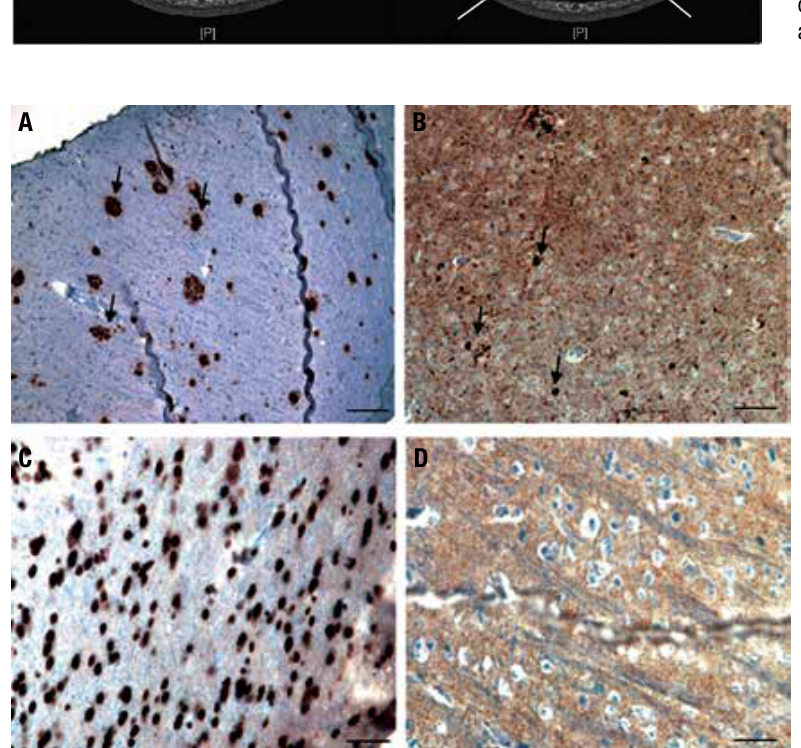
figure 1. (A) Performance on clock drawing test after instruction to insert the hands of the clock to show 8:20.